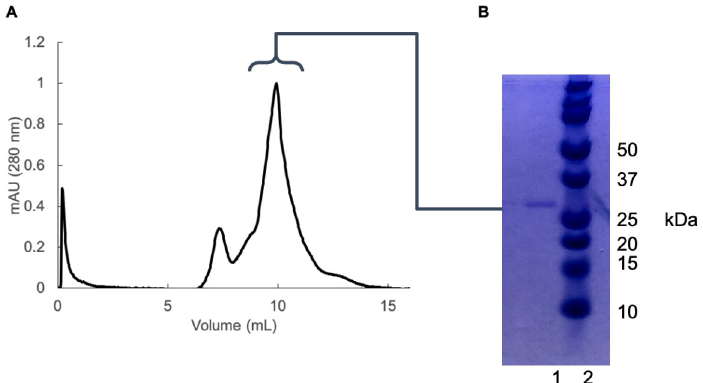
Fig 3. Purification of 13 C, 15 N-labeled SUMO-G0S2 for NMR structural determination. (A) Size exclusion chromatogram of 13 C, 15 N-labeled SUMO-G0S2 showed the protein eluted at 11 mL, indicated by the bracket above, where the full width half maximum (FWHM) of the peak was pooled for the Coomassie gel. (B) Coomassie blue stained SDS-PAGE of 13 C 15 N-labeled SUMO-G0S2 after SEC. Lane 1 : Approximately 1 μ g of SUMO-G0S2 from peak 2 shown on (A). Lane 2 : molecular marker.